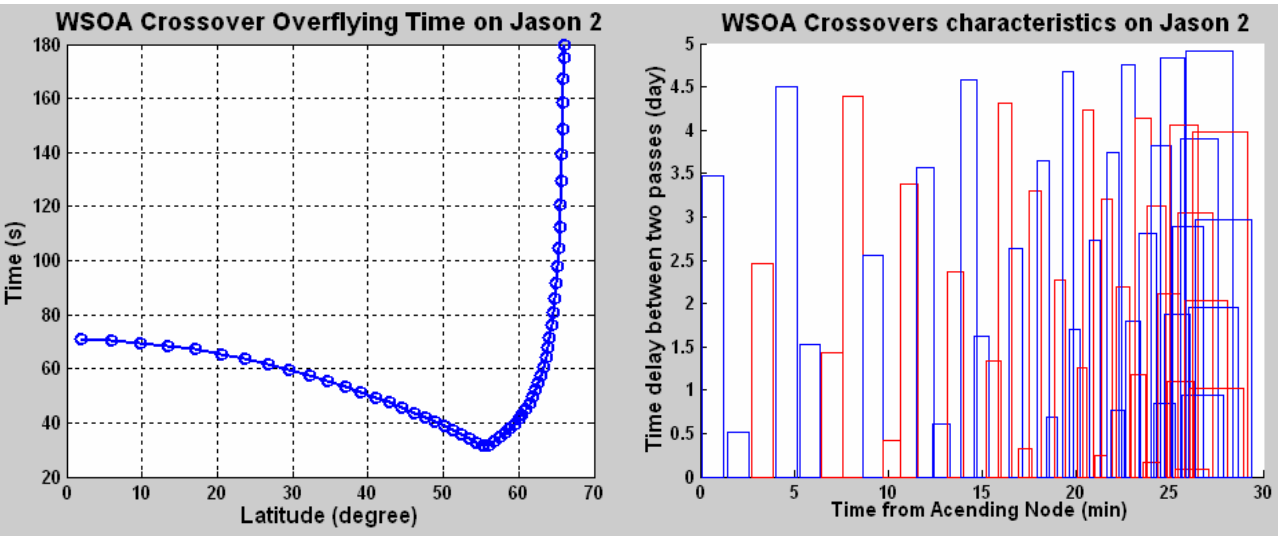
Figure 16. (a) Latitudinal Dependence of the interval between successive crossovers (b) WSOA Jason- 2 crossovers characteristics: blue refers to ascending tracks first and red to descending tracks first; each rectangle corresponds to one crossover, its width defining how long it is over flown.